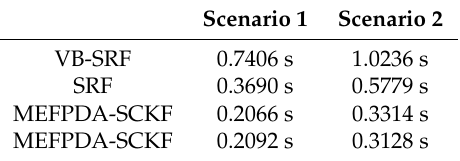
( c ) p c = η 0 = 0.3 Figure 4. RMS target position errors with different mistuned clutter probabilities in Scenario 1. Table 2. Computation time of the four filters with 100 Monte Carlo runs for two